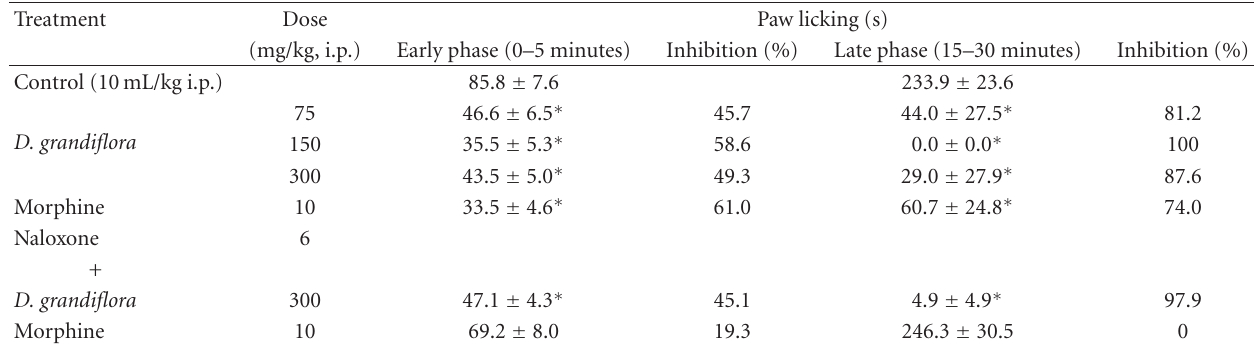
Table 2: E ff ect of EDgP on formalin-induced licking in